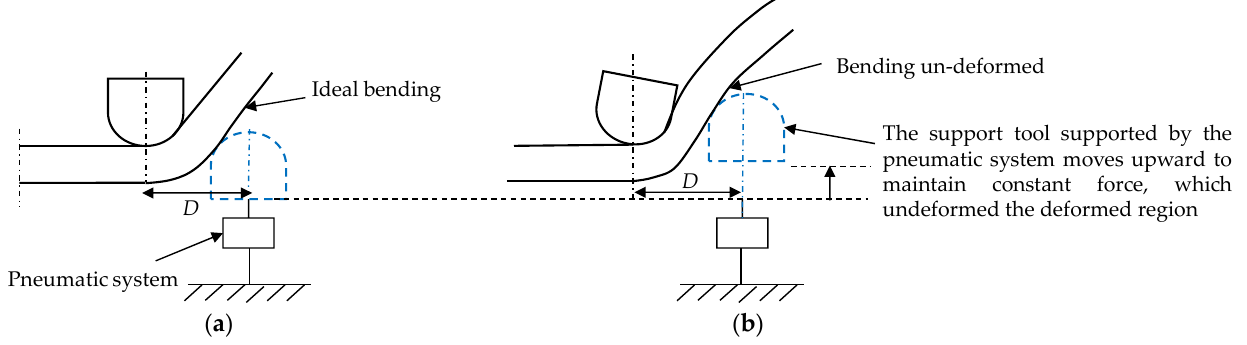
Figure 17. Forces and relative positions of tools in local deformation area in DSIF. ( a ) Ideal condition; ( b ) over-bending (reprinted with permission from Peng et al. [58], Copyright 2019 Elsevier). Zhu et al. [59] studied the continuous contact and points-contact base DSIF. In the